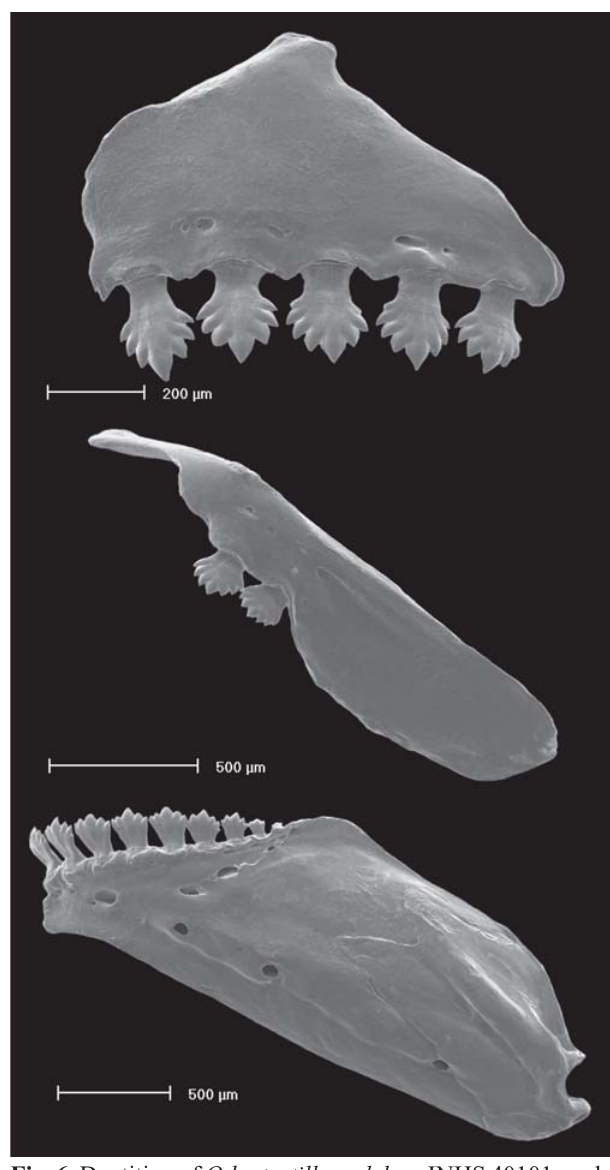
Fig. 6. Dentition of Odontostilbe pulchra , INHS 40101, male 32.5 mm SL: left premaxilla (top), maxilla (middle), and dentary (bottom), lateral view. Scanning electron micrograph